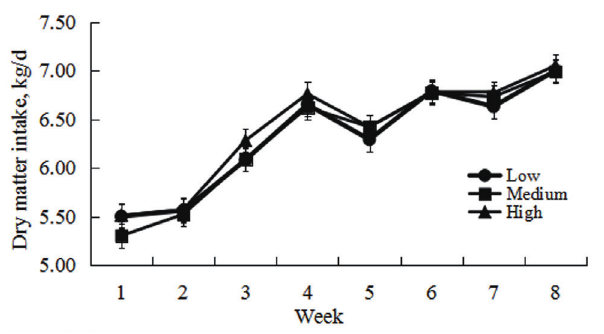
Figure 1. Change in dry matter intake of heifers fed diets containing different dietary protein level. The average dry matter intake were 6.31, 6.31, 6.39 kg/d for low, medium, and high group,